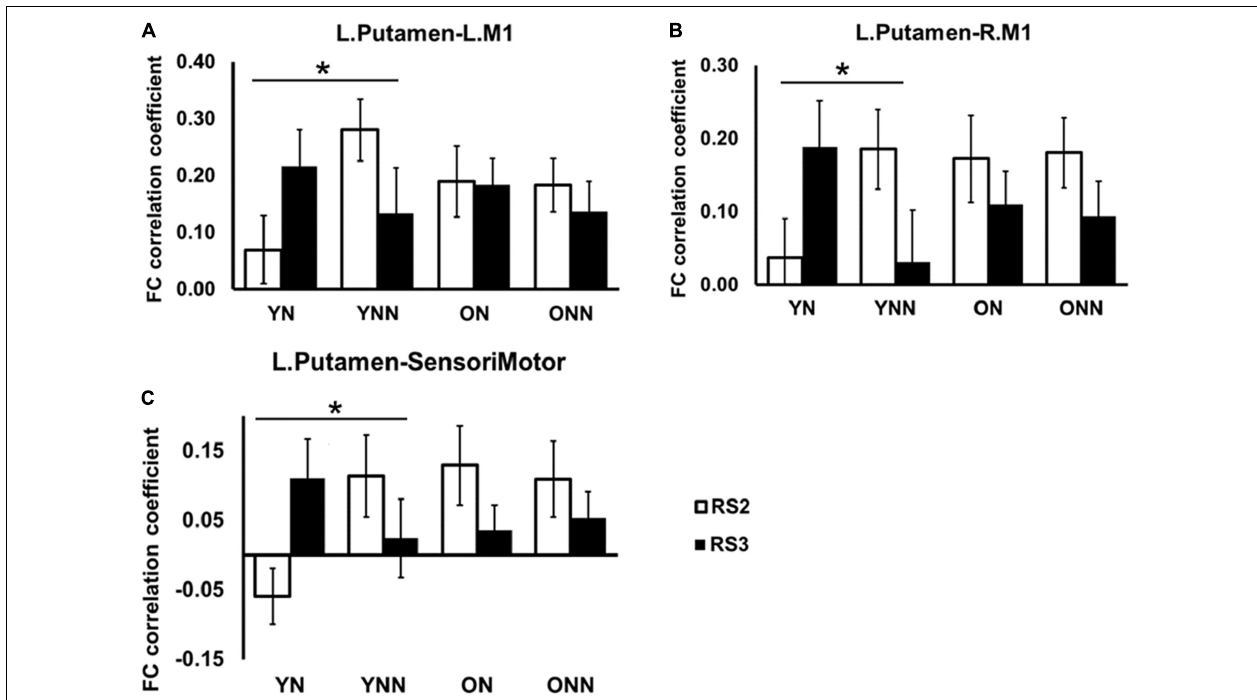
FIGURE 6 | Post hoc analysis of the increased FC between left putamen and motor cortex in YN group following nap. Significant sleep × session interaction effects on FC were observed in the young group between (A) left putamen and left M1; (B) left putamen and right M1; (C) left putamen and sensorimotor, while no such effect was found in the older group. *Indicates significant sleep × session interaction effects in the young group (*pFDR < 0.05). L., left; R., right; M1, primary motor cortex. YN, Young Nap; YNN, Young No Nap; ON, Older Nap; ONN, Older No Nap.